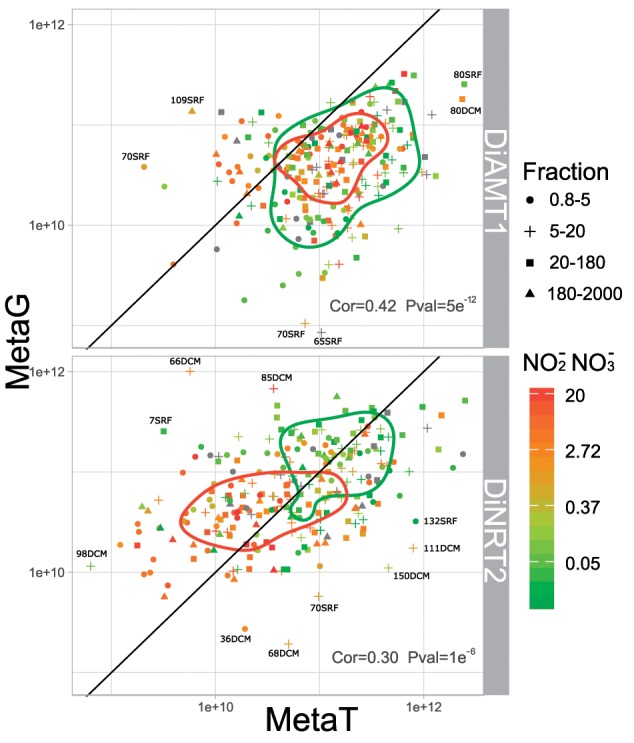
Scatterplot of the occurrences of DiAMT1 and DiNRT2 in the metatranscriptome and metagenome data set. Each dot corresponds to a sampling station. They are shaped according to the size class (0.8–5 µm; 5–20 µm; 20–180 µm; 180–2,000 µm) and colored according to the NO2−+NO3− concentration as measured in situ. Their ordination in the space is given by the sum of the N transporter unigenes mRNA levels on the x axis and on the sum of the same unigenes abundances in the metagenome on the y axis. A 2-d kernel density estimations of low (<0.4) and high (≥0.4) levels of NO2−+NO3− concentrations (µmol/l) are plotted here as contours. Few stations of interest have been labeled with the sampling station number followed by the sampling depth (i.e., SRF for surface and DCM for deep chlorophyll maximum depth). The Pearson correlation rho and P value have been annotated per gene-family. The correlations are poor and this is due to the behavior of some specific stations acting as outliers. For example, stations 66 and 75 show cases of high DNA abundance and very low mRNA levels, indicating low expression by abundant diatoms. Conversely, the opposite is detected for other stations (e.g., stations 65 and 70), indicating high mRNA levels.